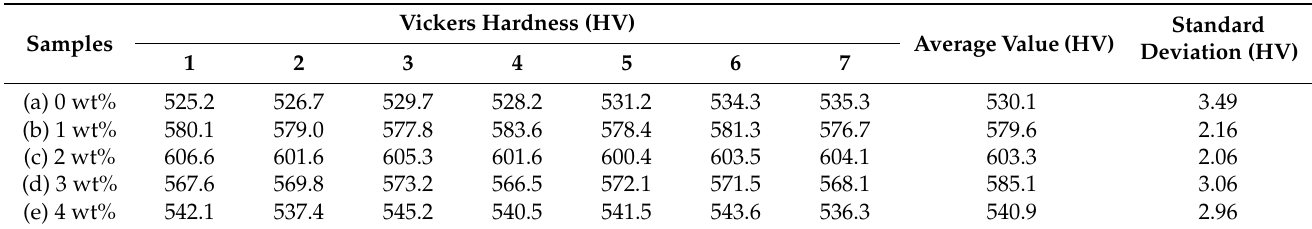
Table 1. Vickers hardness values for seven repetitions of homogeneous-fiber-reinforced MnZn